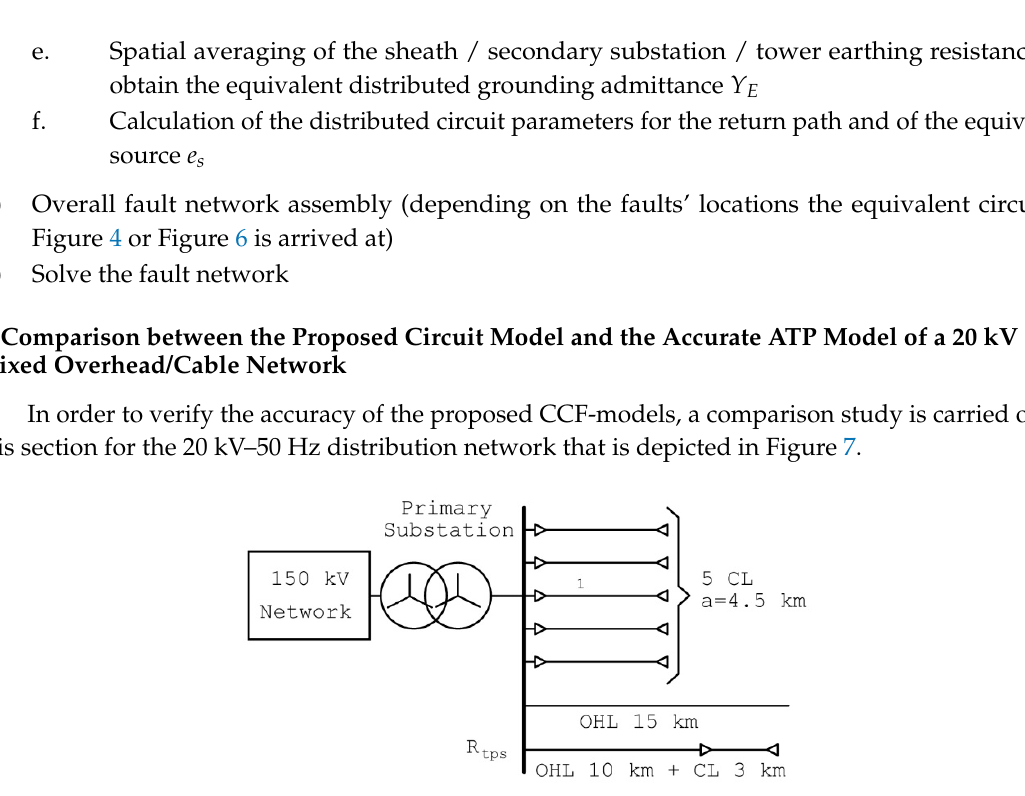
Table 1. Electrical parameters of the main components of the studied 150/20 kV–50 Hz